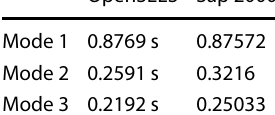
Table 2 Comparison of the period of the first three